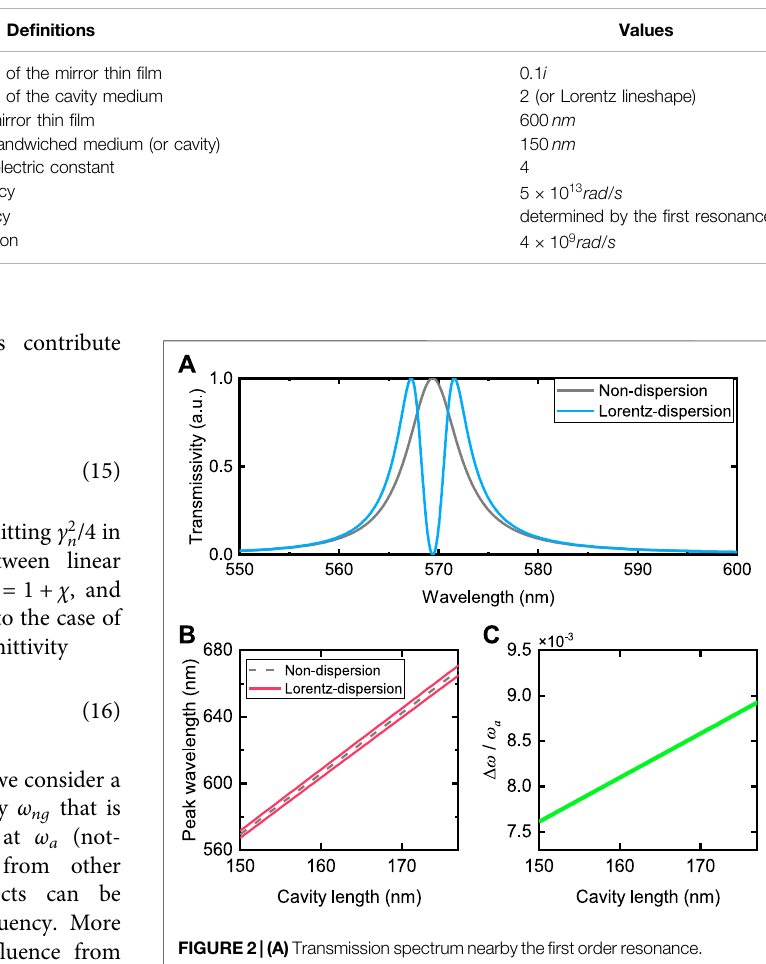
Table 1 as calculated by the transfer-matrix method. The